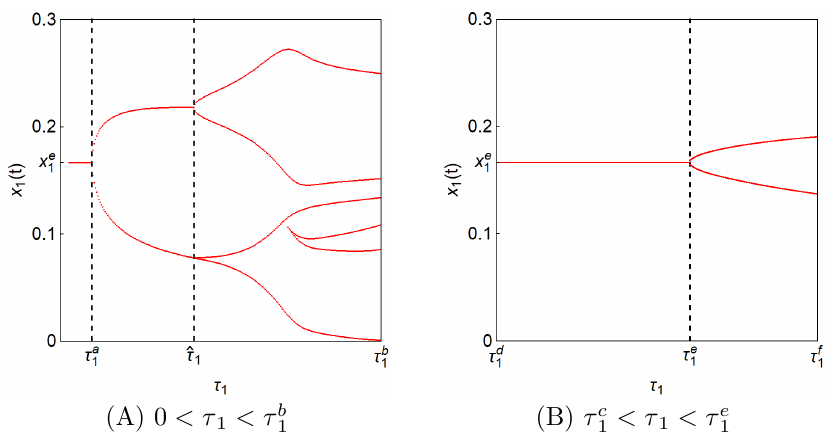
Figure 9. Two bifurcation diagrams along the τ 2 = τ m